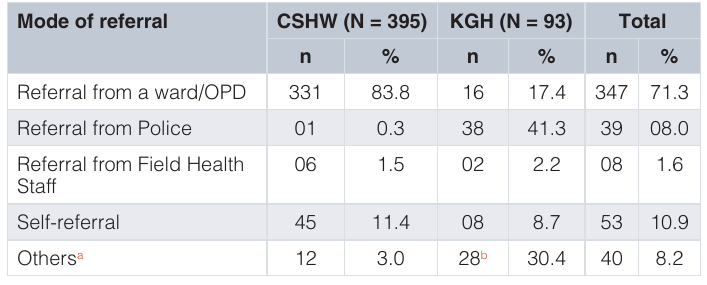
Table 2. Modes of referral to the two gender-based violence care centers (n=488).